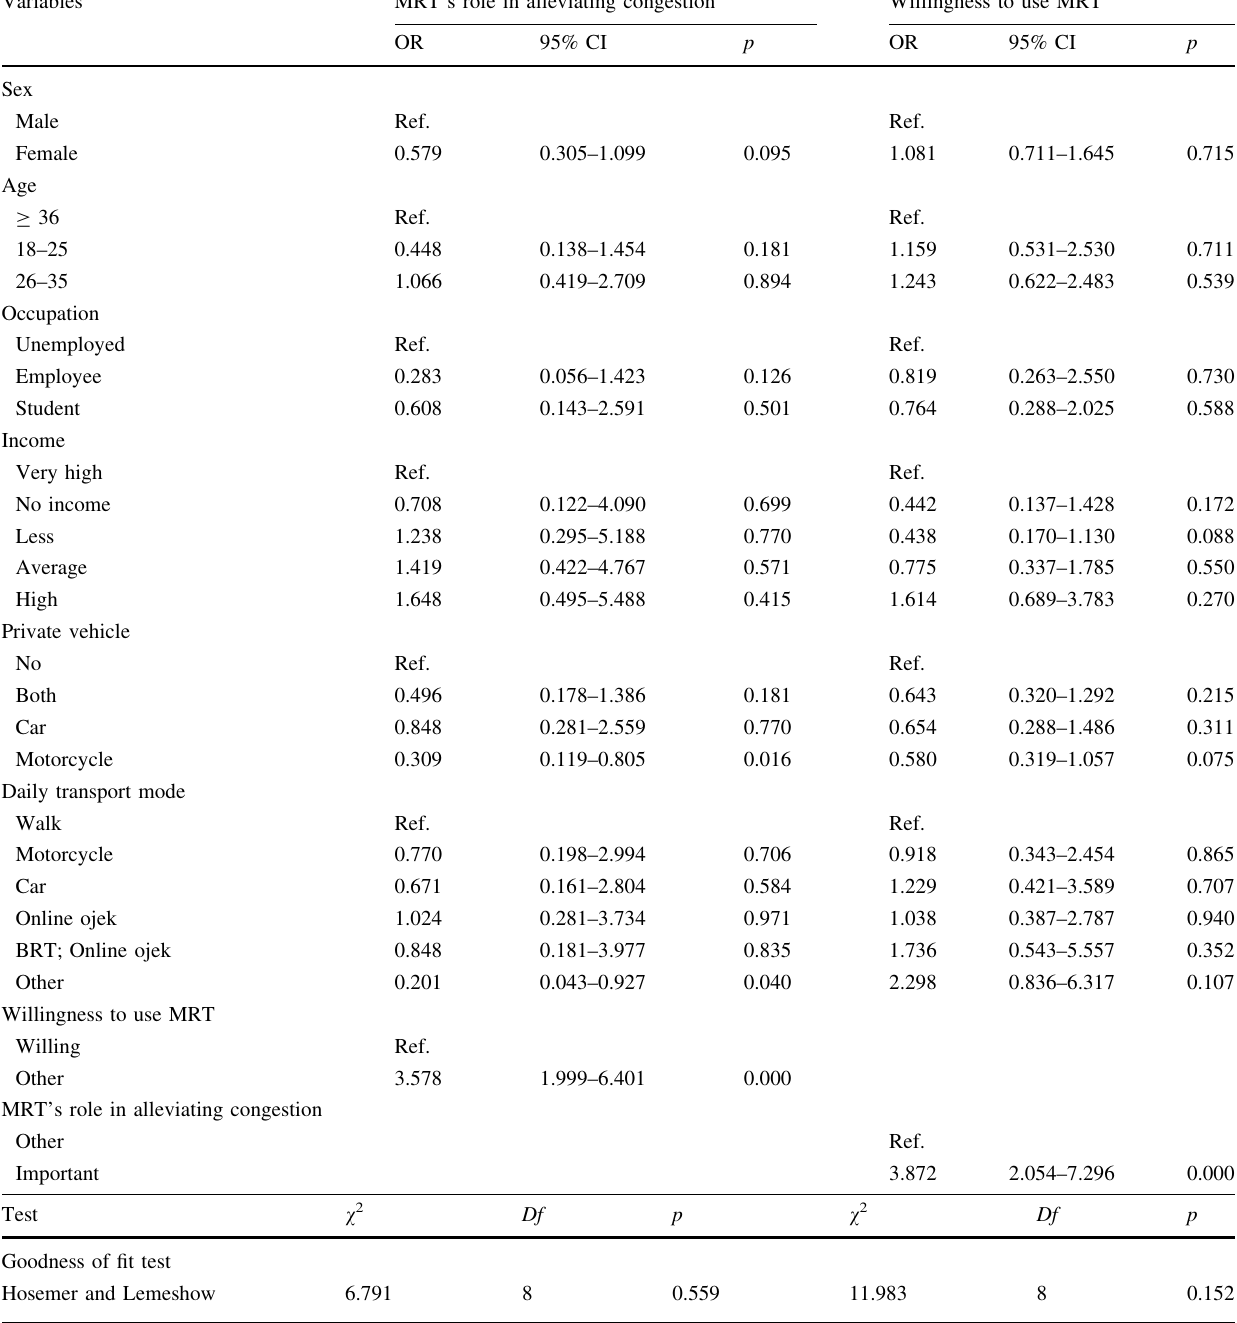
Table 4 Logistic regression analysis of MRT’s role in alleviating congestion and willingness to use